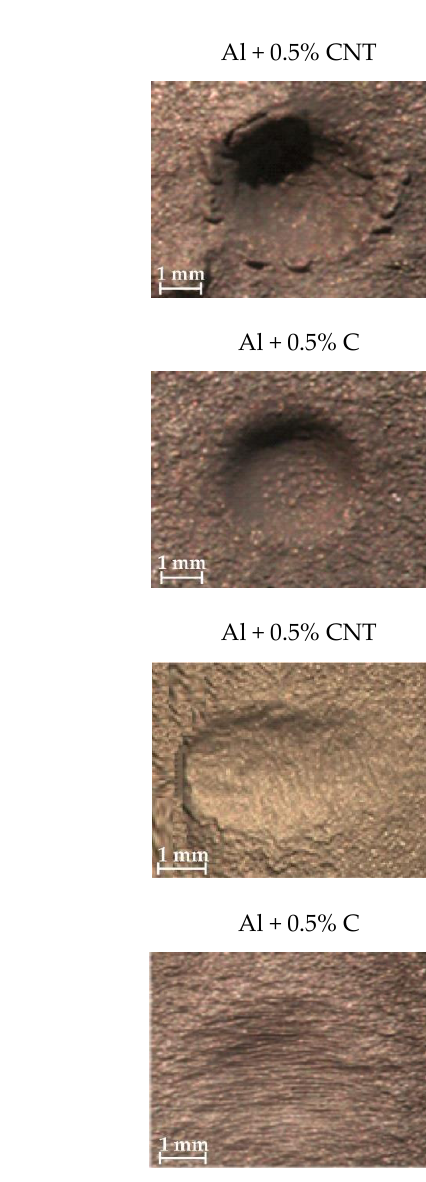
Figure 12. The surfaces of flame-sprayed aluminum and aluminum matrix reinforced with carbon material coatings after erosive wear resistance tests; comparison the erosion effect on samples surfaces for each tested angle of erodent particles incidence. Table 6. Summary of results obtained during the abrasive wear test ASTM G65 [43].